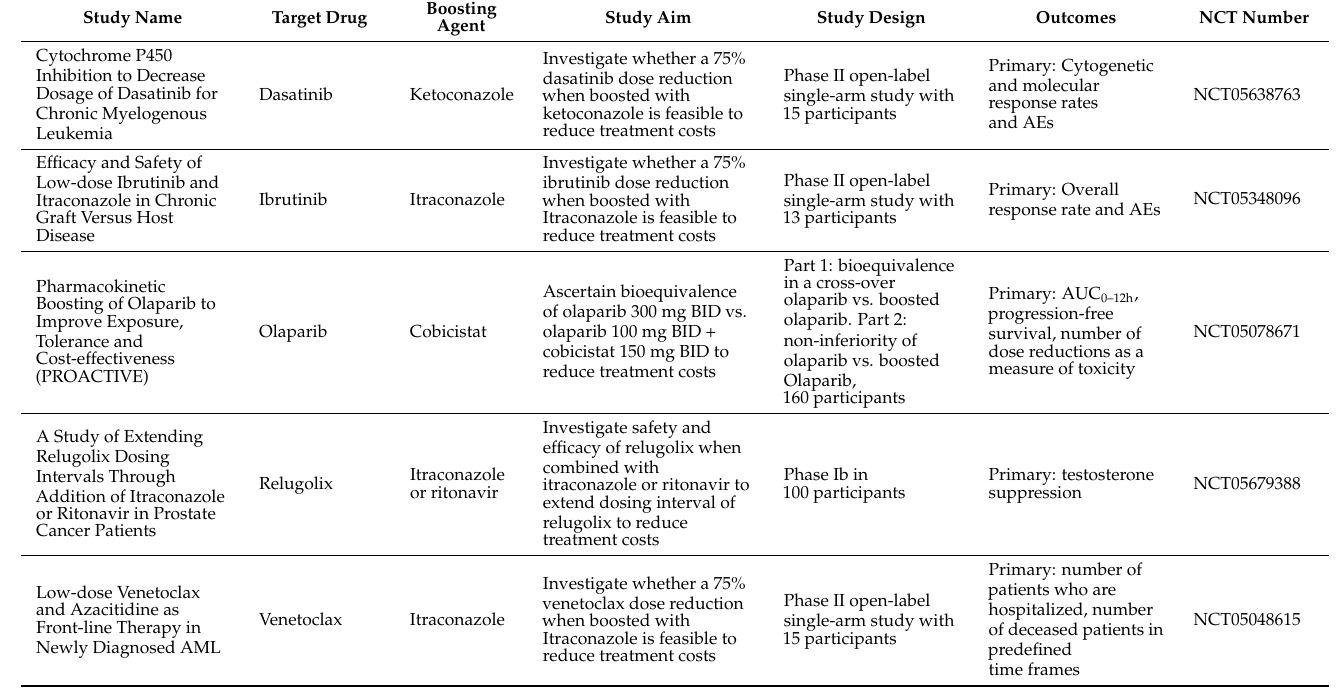
Table 6. Overview of currently ongoing trials on kinase inhibitor boosting ( n =